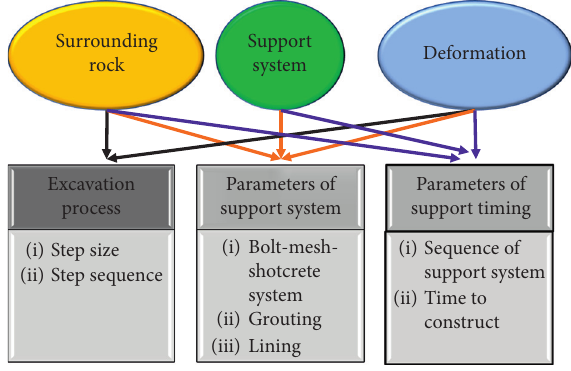
Figure 17: Monitoring information used to assess the risk of large